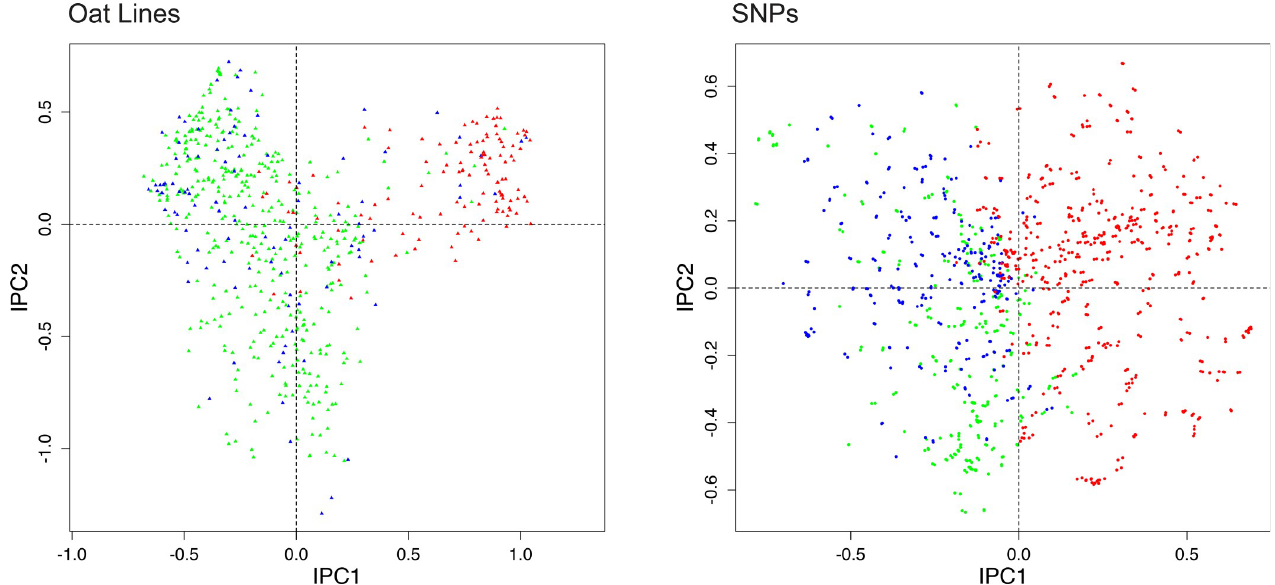
Fig 1. DC-PCA biplot for the oat data, using SNP coding rare = 1 and expert knowledge of the oats. To reduce clutter the biplot uses two panels, with oat lines on the left and SNPs on the right. The 635 oat lines are classified in three groups: 411 spring oats shown in green, 103 world diversity oats in blue, and 121 winter oats in red. Likewise, the 1341 SNPs are classified in three groups based on which oat group has the highest percentage of the rare allele: 372 highest in spring oats shown in green, 345 highest in world diversity oats in blue, and 624 highest in winter oats in red.